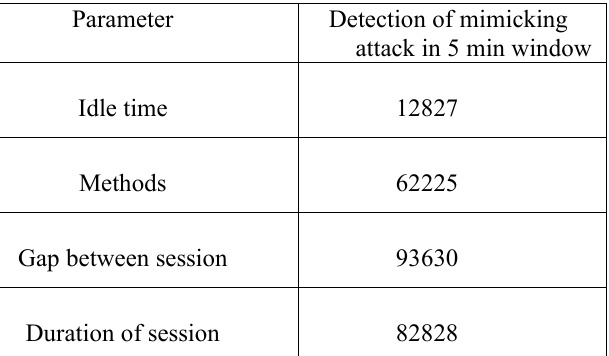
Table 1. Mimicking attack identification with a single